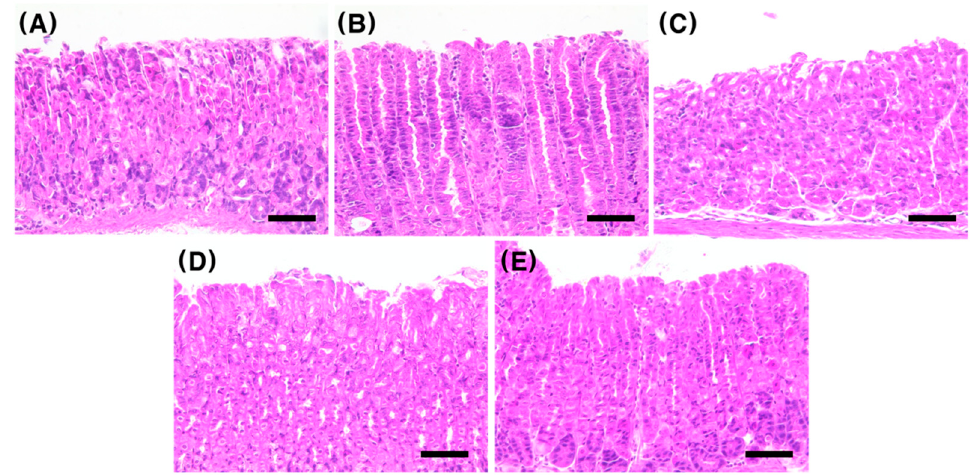
Figure 4. Histological analysis of mouse gastric tissue by H&E staining (original magnification × 400). ( A ) uninfected control group; ( B ) infected HP group; ( C ) infected and treated T group; ( D ) infected and treated 1/2BS group; ( E ) infected and treated 1/2BST group. 1/2, half of the recommended daily intake of salt. Scale bar = 50 μ m.